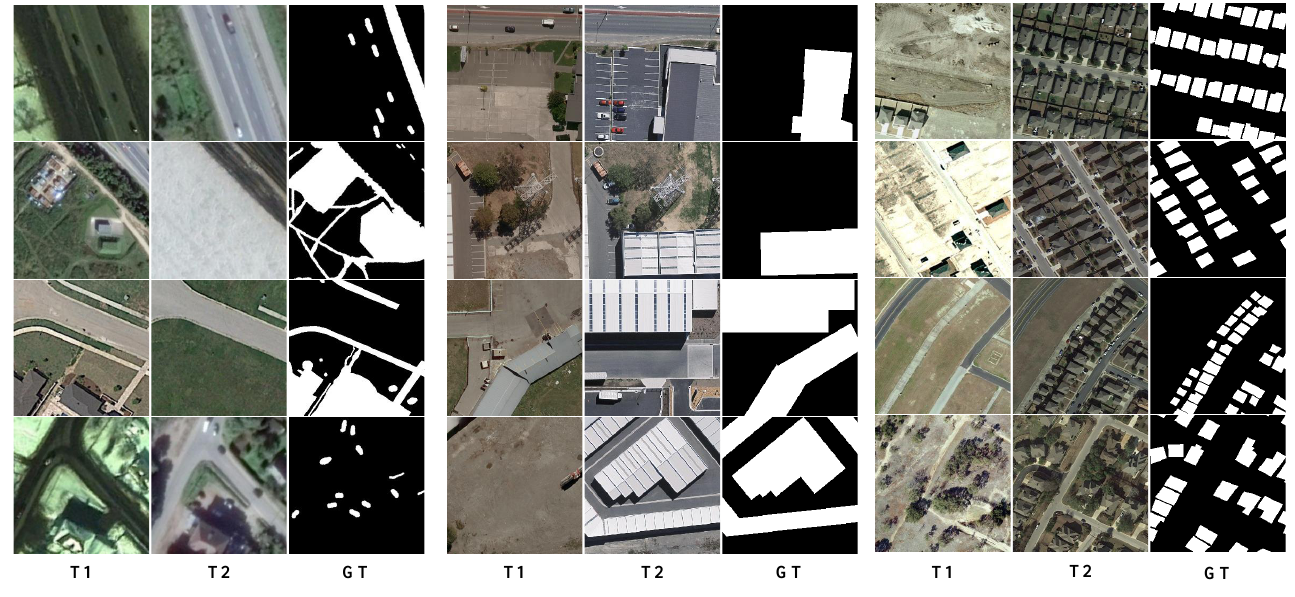
Figure 7. Illustration of samples from three dataset. The samples from left to right are in order from CDD, BCDD,LEVIR-CD. T1 and T2 indicate the bi-temporal image pairs. GT indicates the ground